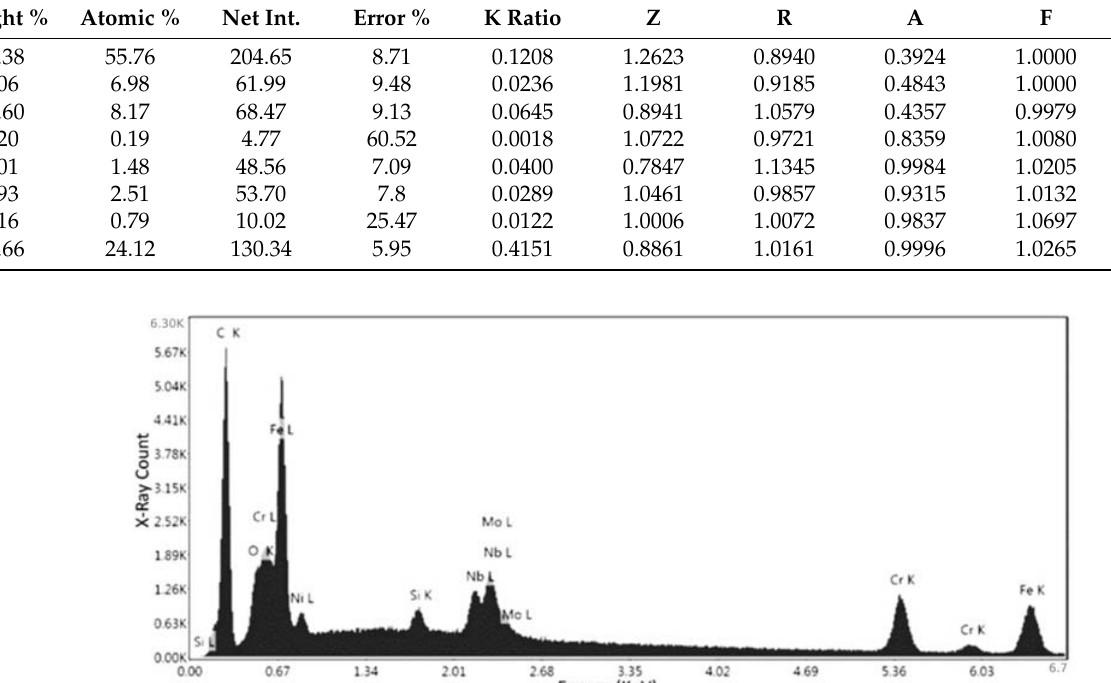
Figure 18. EDS measurement of the second point for specimen No. 5 to study the lack of fusion defect. Table 9. Chemical composition as the result of EDS analysis in specimen No. 5 (second point) to study the lack of fusion defect.